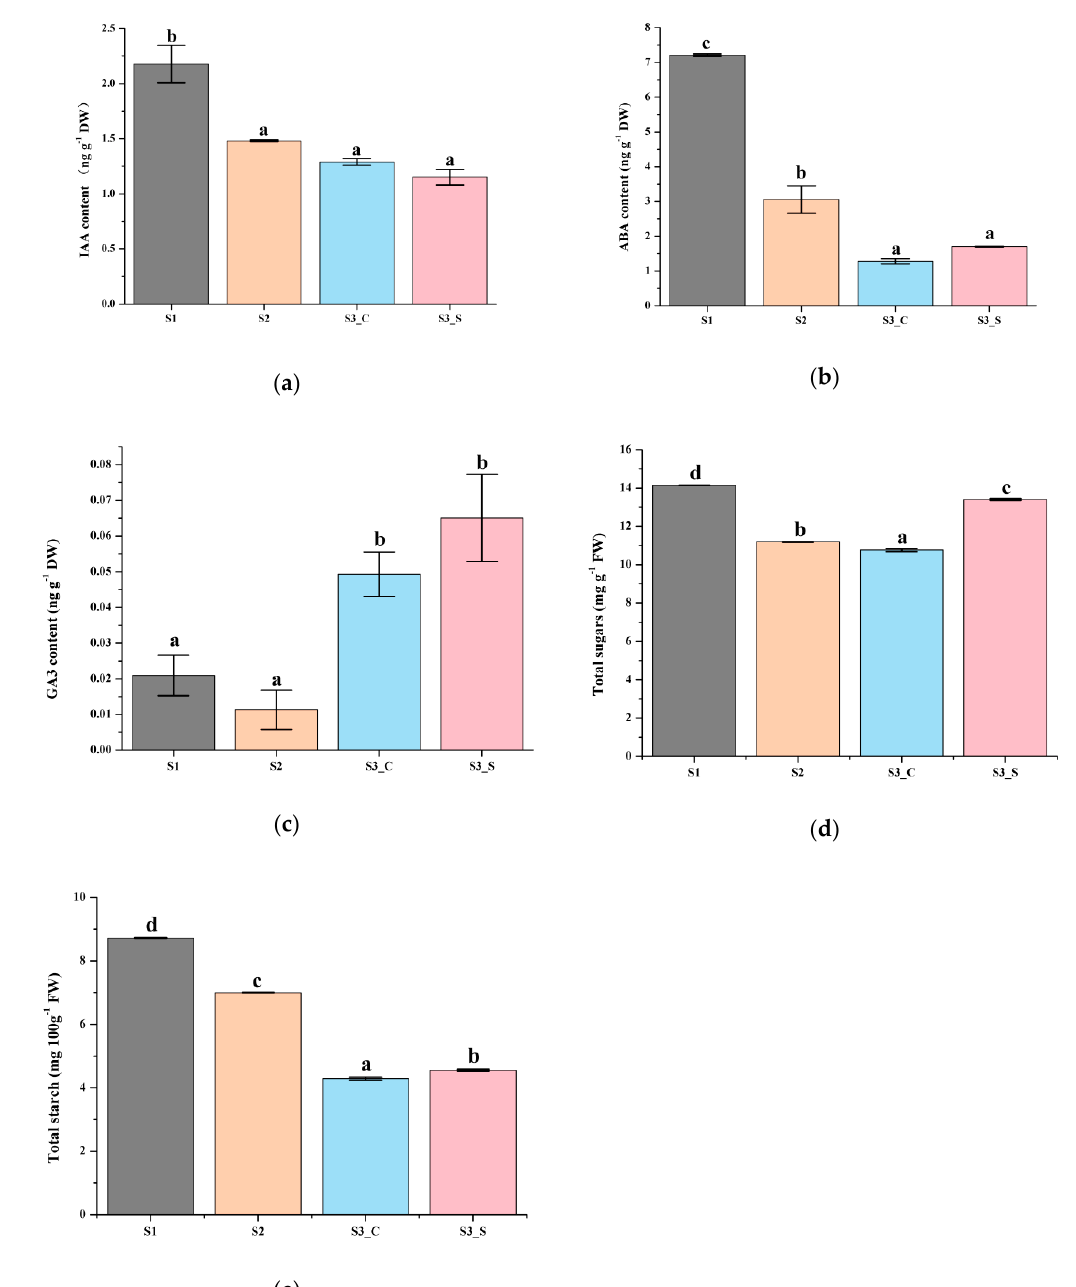
Figure 3. Biochemical analysis of leaves at different developmental stages. ( a ) IAA content at S1-S3. ( b ) ABA content at S1–S3. ( c ) GA3 content at S1–S3. ( d ) Total sugar content at S1–S3. ( e ) Starch content at S1–S3. Different letters among stages indicate significant differences at p ≤ 0.05 based on ANOVA (Tukey test).